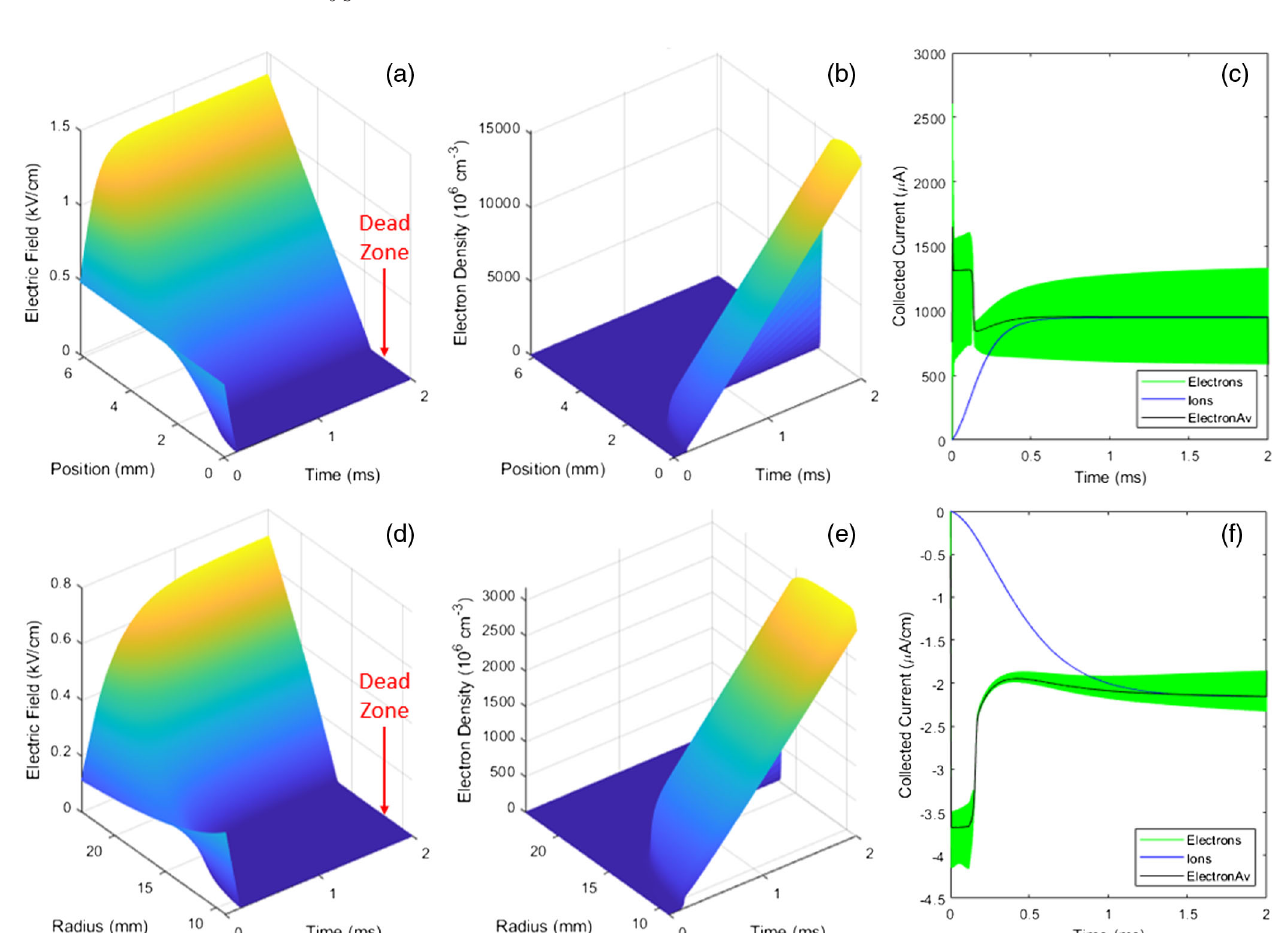
FIG. 5. Response to a 120-kW loss of a 1-MHz beam on a protection collimator over 2 ms. (a) – (c) Response of a PIC placed at r ¼ 0 . 5 m and at the radiation peak in z in Fig. 4, as a function of time and, in (a),(b), of position between adjacent plates. (d) – (f) Response of a LION at r ¼ 1 m and spanning the radiation peak, as a function of time and, in (d),(e), of the position between the inner and outer coaxial conductors. (a),(d) Electric field. (b),(e) Electron density. (c),(f) Ion and electron currents collected at the cathode and anode, respectively. Because the electron current fluctuates over a wide band during the 1-MHz period, the average current in each period is also